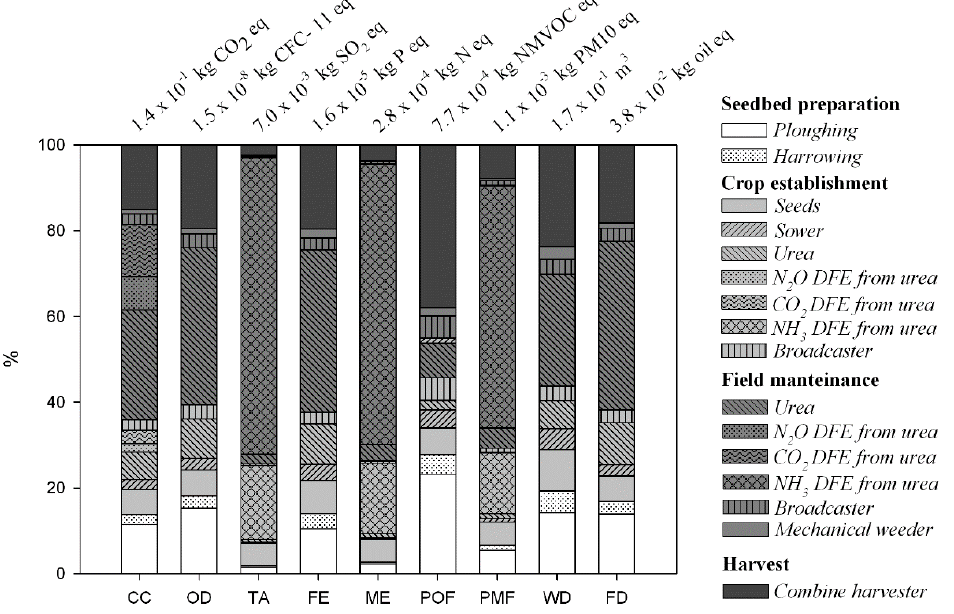
Figure 3. Characterization graph of impacts along the WS feedstock agronomic supply chain, related to the production of 1 kg of butane-1,4-diol bio. Absolute values of impacts are reported on top of each impact category. DFE: direct field emissions from the cropped soil.